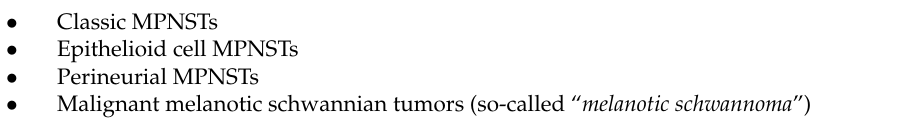
Table 15. Classification of malignant peripheral nerve sheath tumors (MPNSTs).